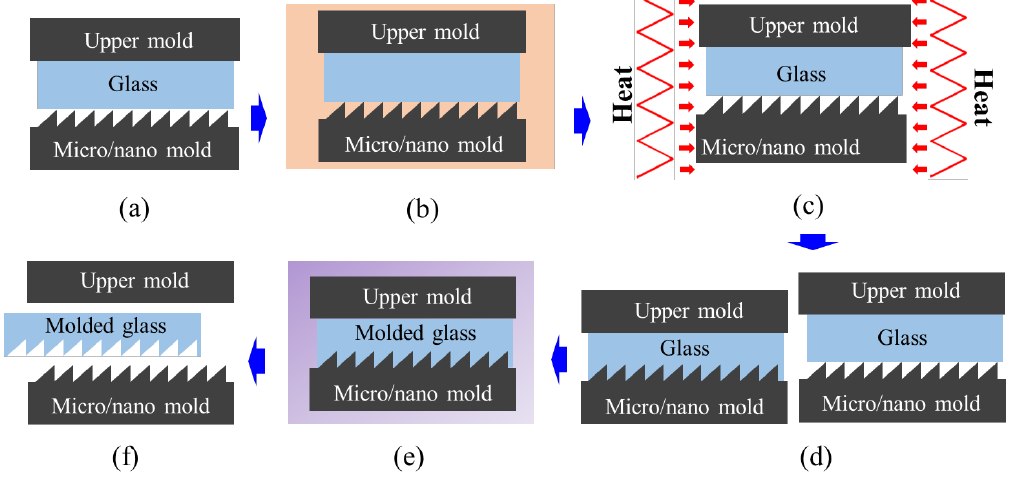
Figure 1. Schematic illustration of the glass molding process: ( a ) loading of the glass material between lower and upper molds, ( b ) purging of the chamber, ( c ) heating of the molding chamber to the molding temperature, ( d ) clamping and pressing of the glass material against the upper and lower molds, ( e ) cooling of the molded glass, and ( f ) unloading of molded glass.